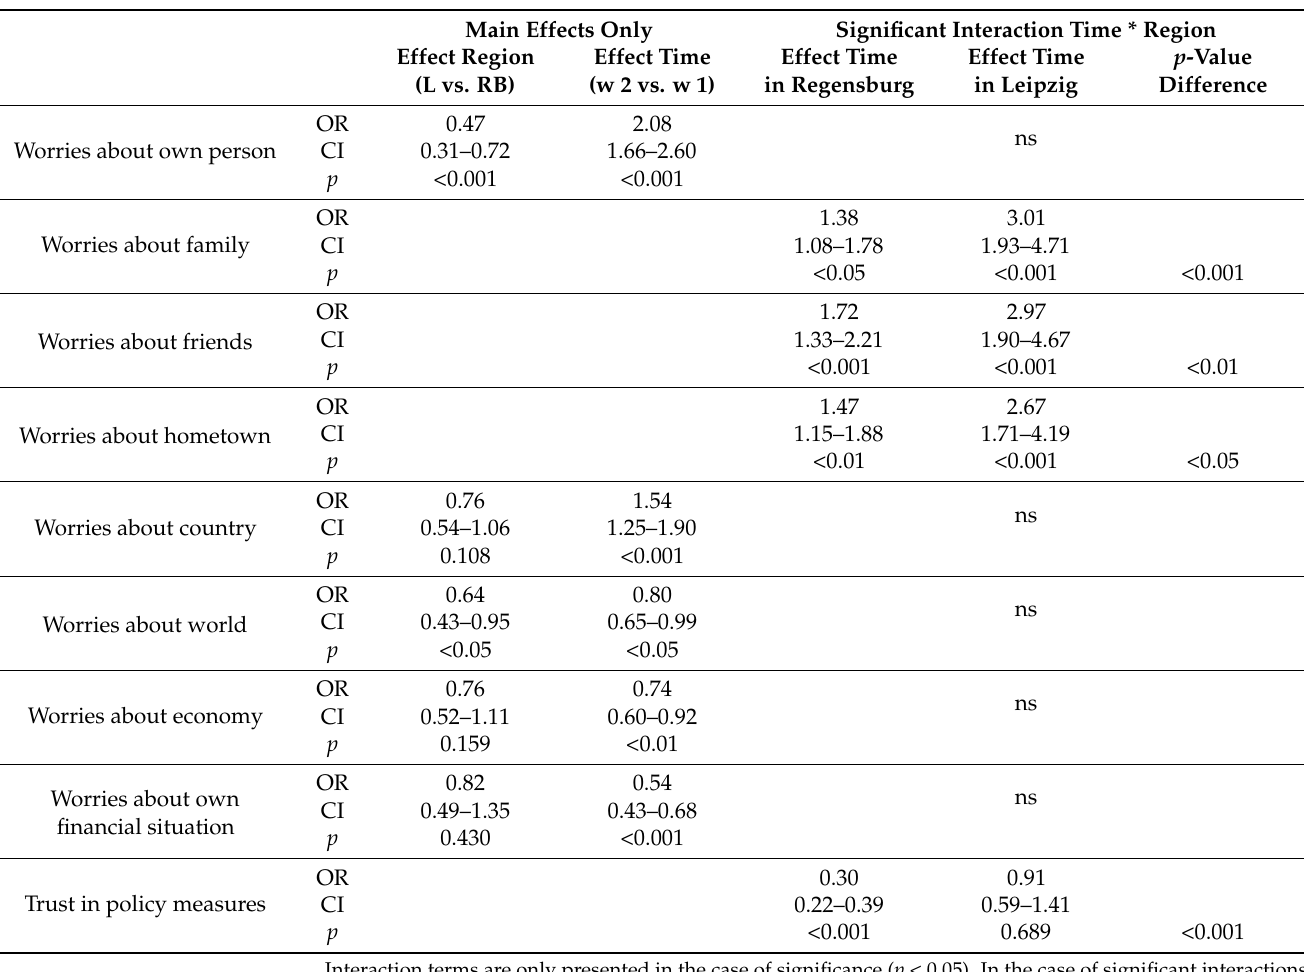
Table 2. Effects of time (wave 1 versus wave 2) and region (Leipzig versus Regensburg) on COVID- 19-related worries and trust in policy